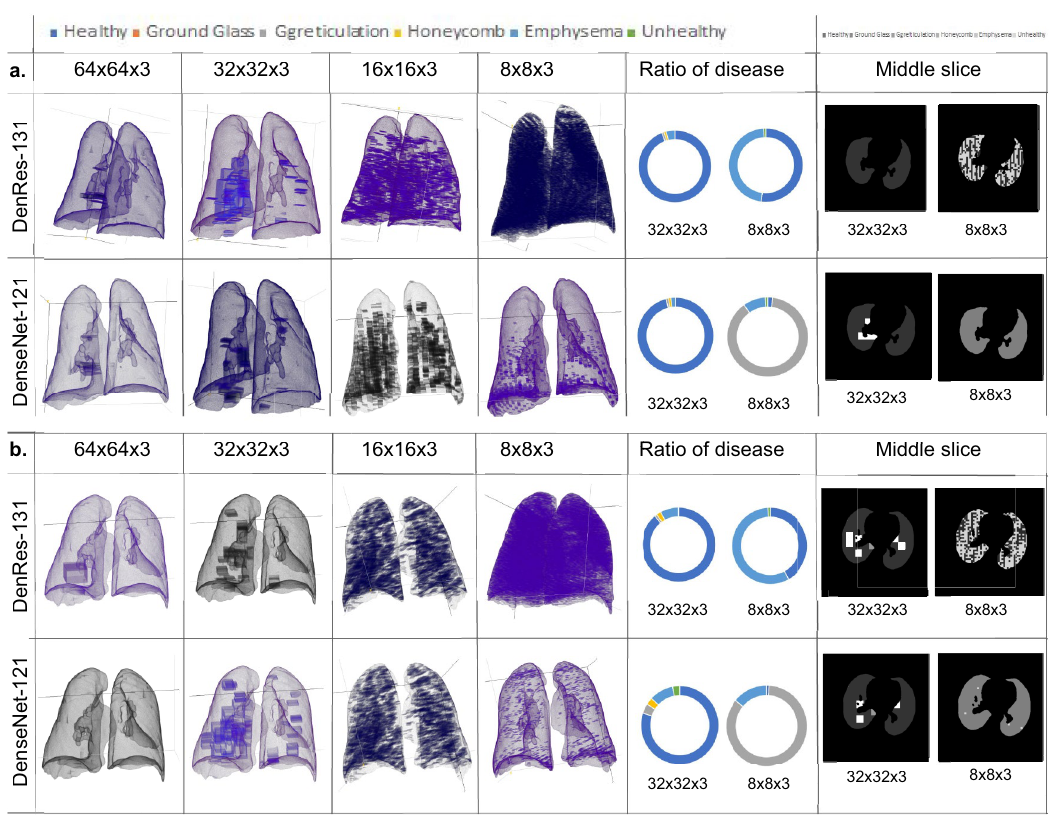
Figure 5. Results of two different patient of the ‘seen’ testing cohort. ( a , b ) The 3D mapping of two patients ( a , b ) for the DenseNet-121 and DenRes-131 in the multi-classification task. Four different 3D patch sizes volume: 64 × 64 × 3 , 32 × 32 × 3 , 16 × 16 × 3 , and 8 × 8 × 3 height, width and depth respectively are presented. From left to right the four different 3D anatomical lung models, the ratio of diseases results of the patch sizes 32 × 32 × 3 , and 8 × 8 × 3 , and the prediction results of the middle slice of short